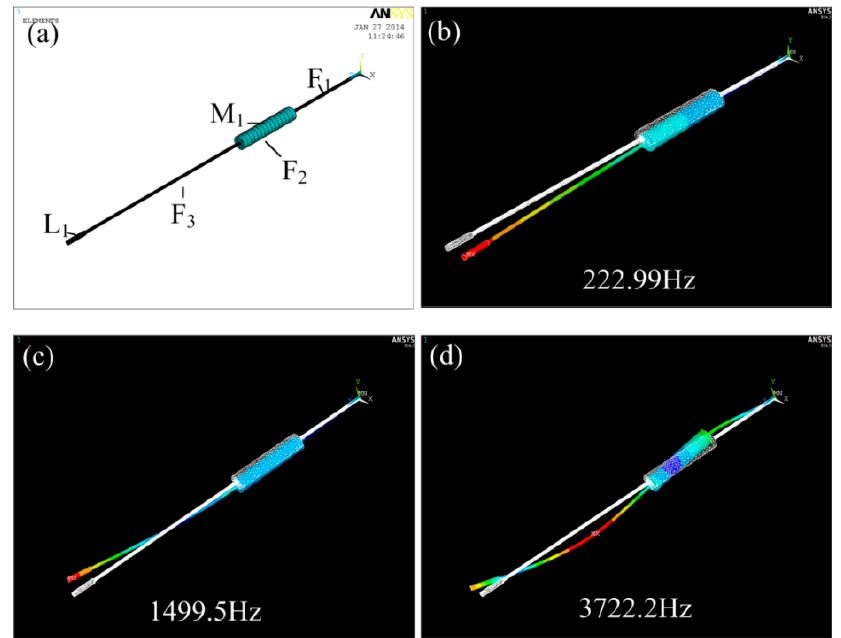
Figure 5. FEA models for modal analysis. ( a ) Whole model for fiber scanner; ( b – d ) presented structure deformation and frequency of the first three order resonant modes.